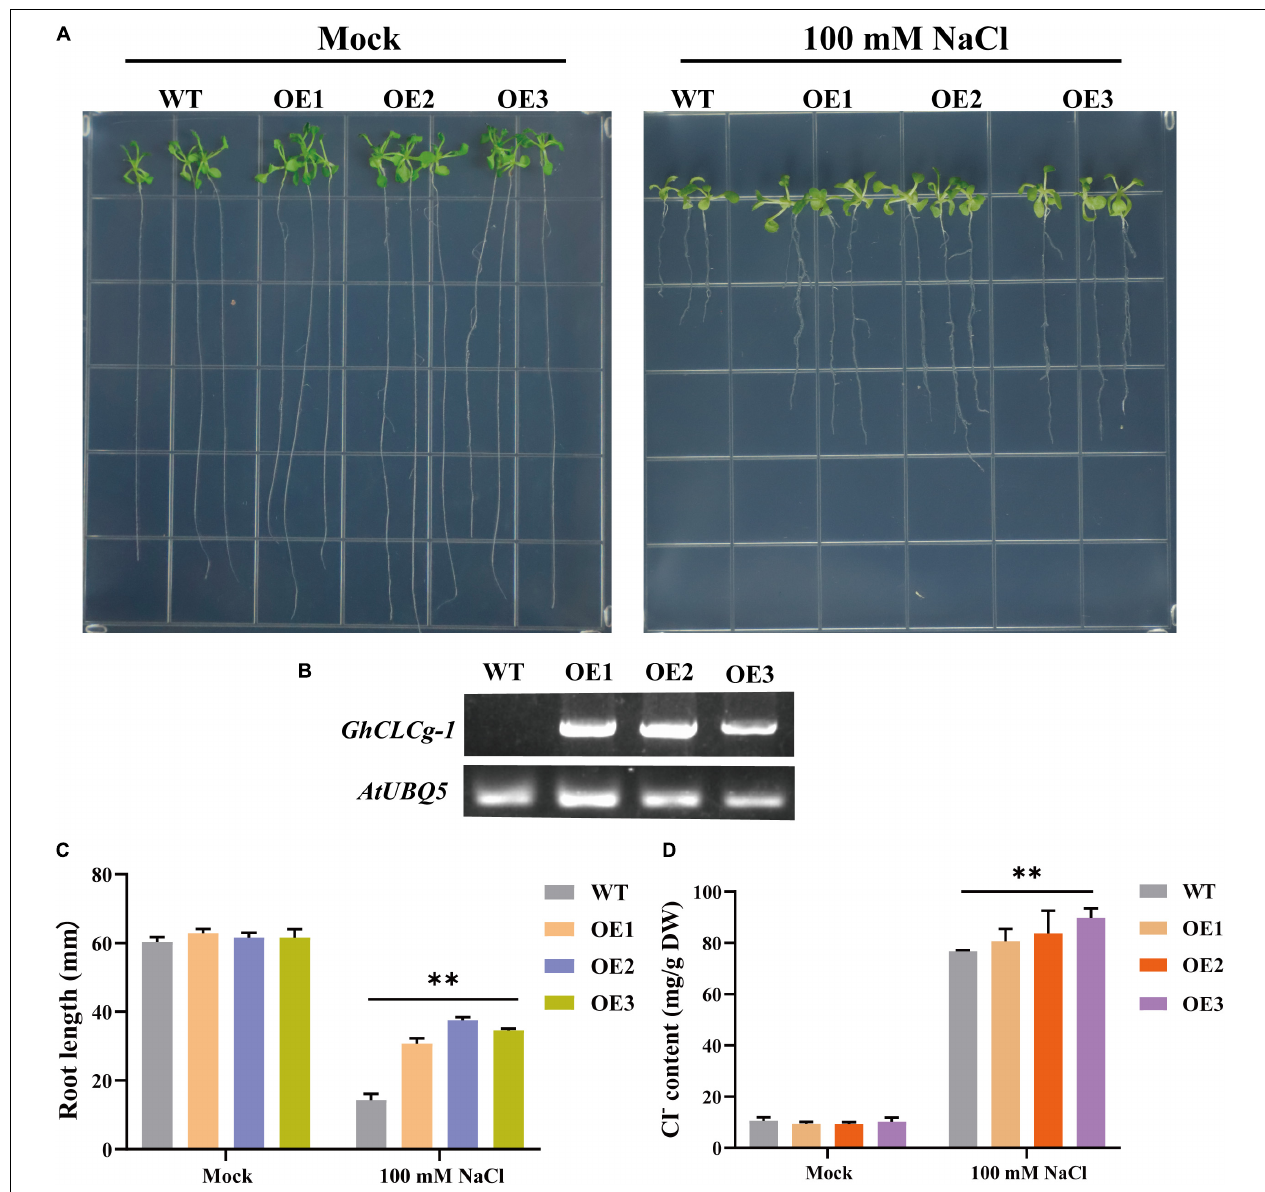
FIGURE 5 | Effects of overexpressing of GhCLCg-1 in Arabidopsis thaliana . (A) Wild-type (WT) and GhCLCg-1 -overexpressing transgenic A. thaliana lines (OE1, OE2, and OE3) grown on Murashige and Skoog (MS) medium (Mock) and MS medium containing 100 mM NaCl for 21 days. (B) Reverse transcription PCR analysis of GhCLCg-1 expression levels in WT, OE1, OE2, and OE3 plants, with AtUBQ5 used as an internal control. (C) Comparison of the WT, OE1, OE2, and OE3 root lengths. (D) Comparison of the WT, OE1, OE2, and OE3 chloride contents. Data are presented as the mean ± standard deviation (SD) of three biological replicates ( ∗∗ p < 0.01, t